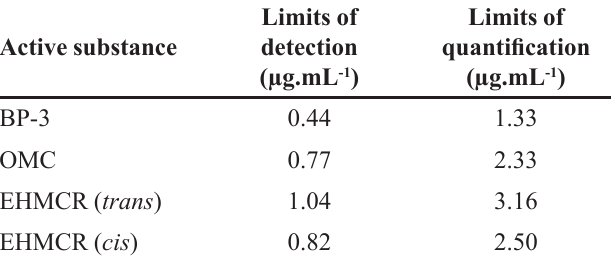
TABLE IV - Limit of detection and limit of quantification of octyl- p -methoxycinnamate (OMC); benzophenone-3 (BP-3) and ethylhexylmethoxycrylene (EHMCR)